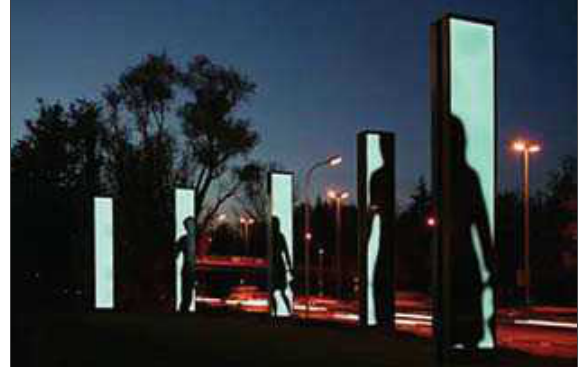
Fig. 18. Lighting of Danube canal, Vienna, 2008